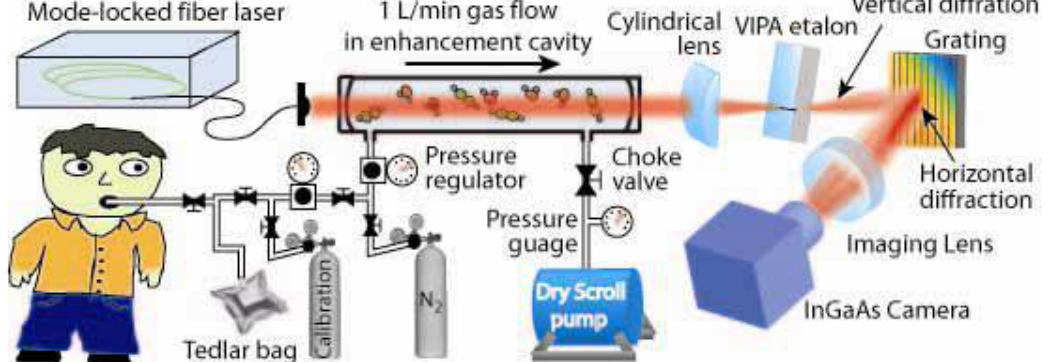
Figure 4. Schematic of the cavity-enhanced direct-frequency-comb spectrometer, along with the gas handling system for breath analysis (reproduced with permission from the Optical Society of America